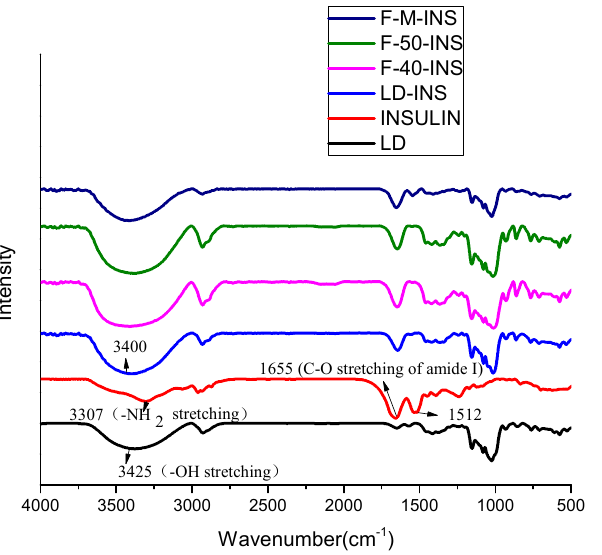
Figure 3. FT-IR spectra of LD, INSULIN, LD-INS, F-40-INS, F-50-INS, and F-M-INS inclusion complexes.